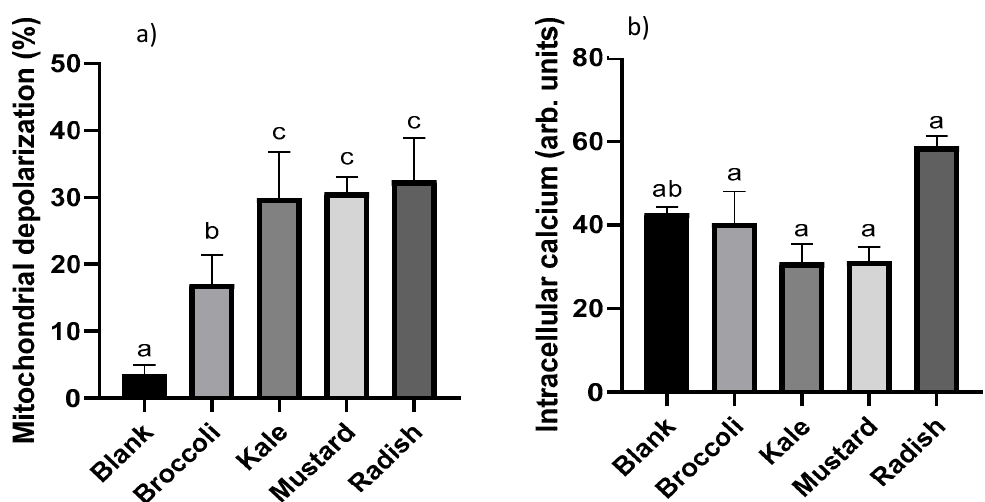
Figure 3. Evaluation of the changes in the mitochondrial membrane potential ( a ) and intracellular calcium levels ( b ) produced after incubation for 24 h with bioaccessible fractions obtained from Brassicaceae microgreens (diluted 1:10 v / v in DMEM) in Caco-2 cells. Results are expressed as mean ± standard deviation (n = 4) in two independent assays. Di ff erent lowercase letters (a–c) indicate statistically significant di ff erences ( p < 0.05) among samples. Positive control (5-FU) produced a marked mitochondrial depolarization (6-fold) and raise of intracellular Ca 2 + levels (64%) compared to control (untreated cells).